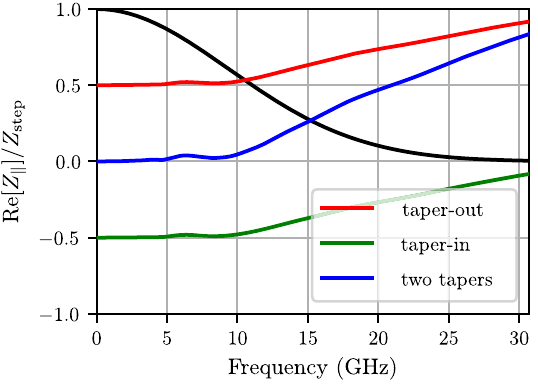
FIG. 7. Comparison of the loss factor of a taper-out from simulations (ABCI) and analytic predictions using Eq. (12) for different taper